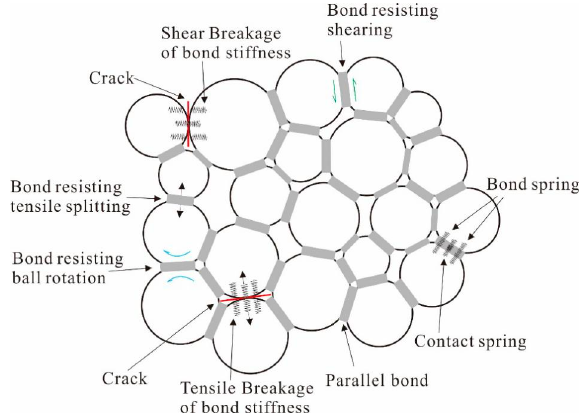
Figure 1. Illustration of the parallel bond model (modified from Cho [42]).